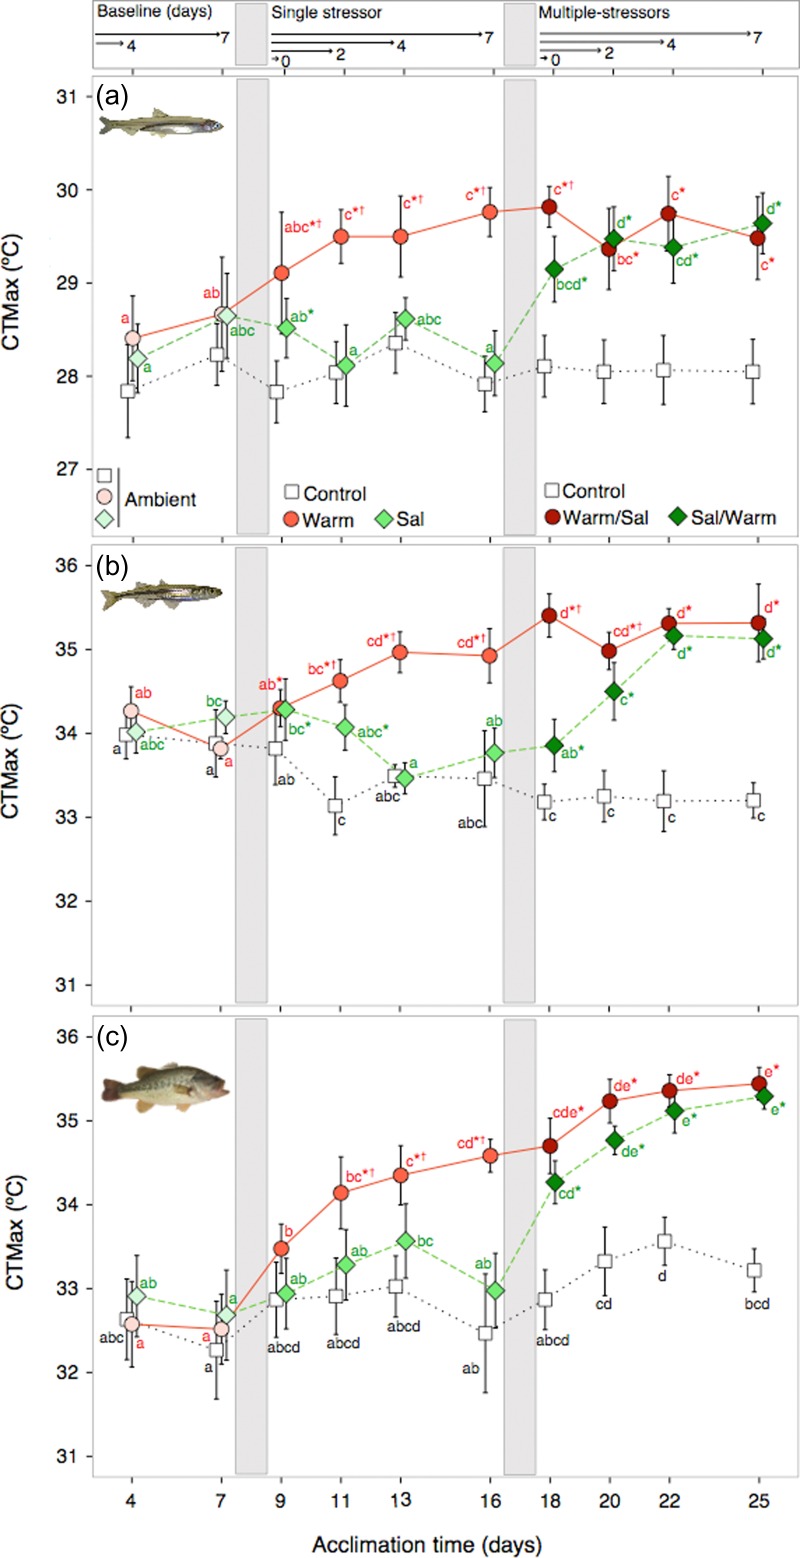
Critical thermal maximum (CTMax) ± 95% confidence (CI) of ‘San Francisco Estuary species’. species. Within each panel, (a) Delta Smelt, (b) Mississippi Silversides and (c) Largemouth Bass average CTMax is given for n = 10–12 individuals per point. Note the y-axis of Delta Smelt differs from the other species. Vertical gray bars indicate exposure changes from the baseline to initial single stressors and then to subsequent multiple-stressor periods. Letters indicate significant differences (P < 0.05) in CTMax within a given stressor regime across acclimation time (Control [white], Warm/Sal [red], and Sal/Warm [green]). Asterisks indicate a difference from the control at each day, and daggers represent a difference between Warm/Sal and Sal/Warm stressor regimes at each day (Tukey, P < 0.05).